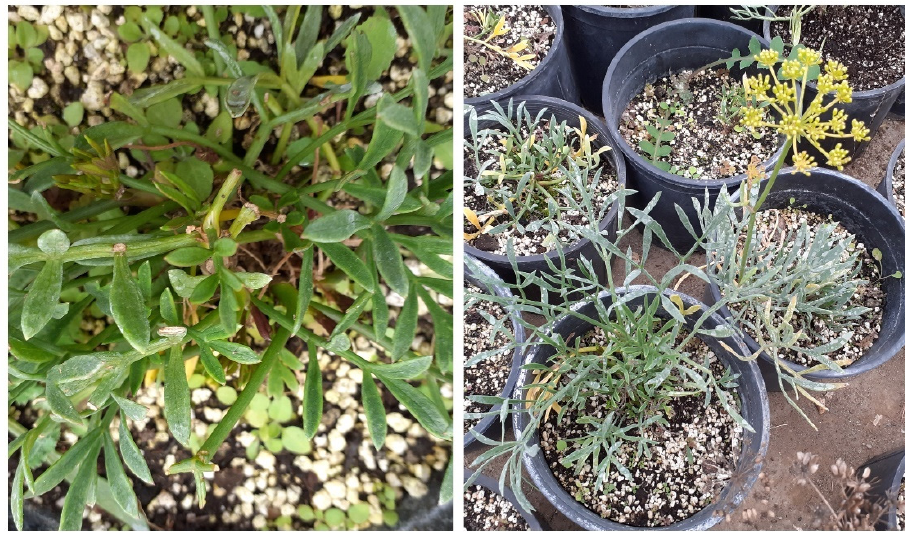
Figure 3. Sea fennel plants at different growth stages ( left picture: fully grown plants; right picture: plants at flowering stage).